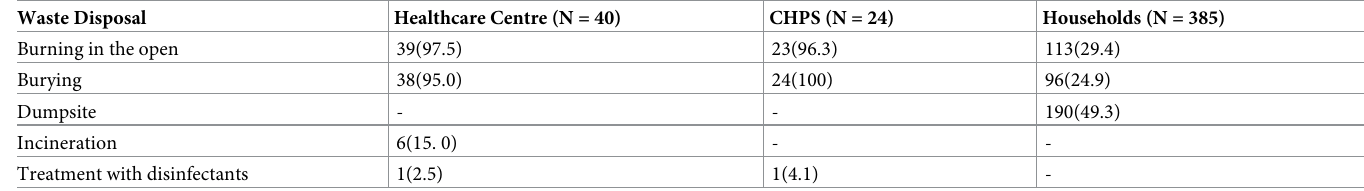
Table 5. Disposal practices of solid medical waste in sub district level.